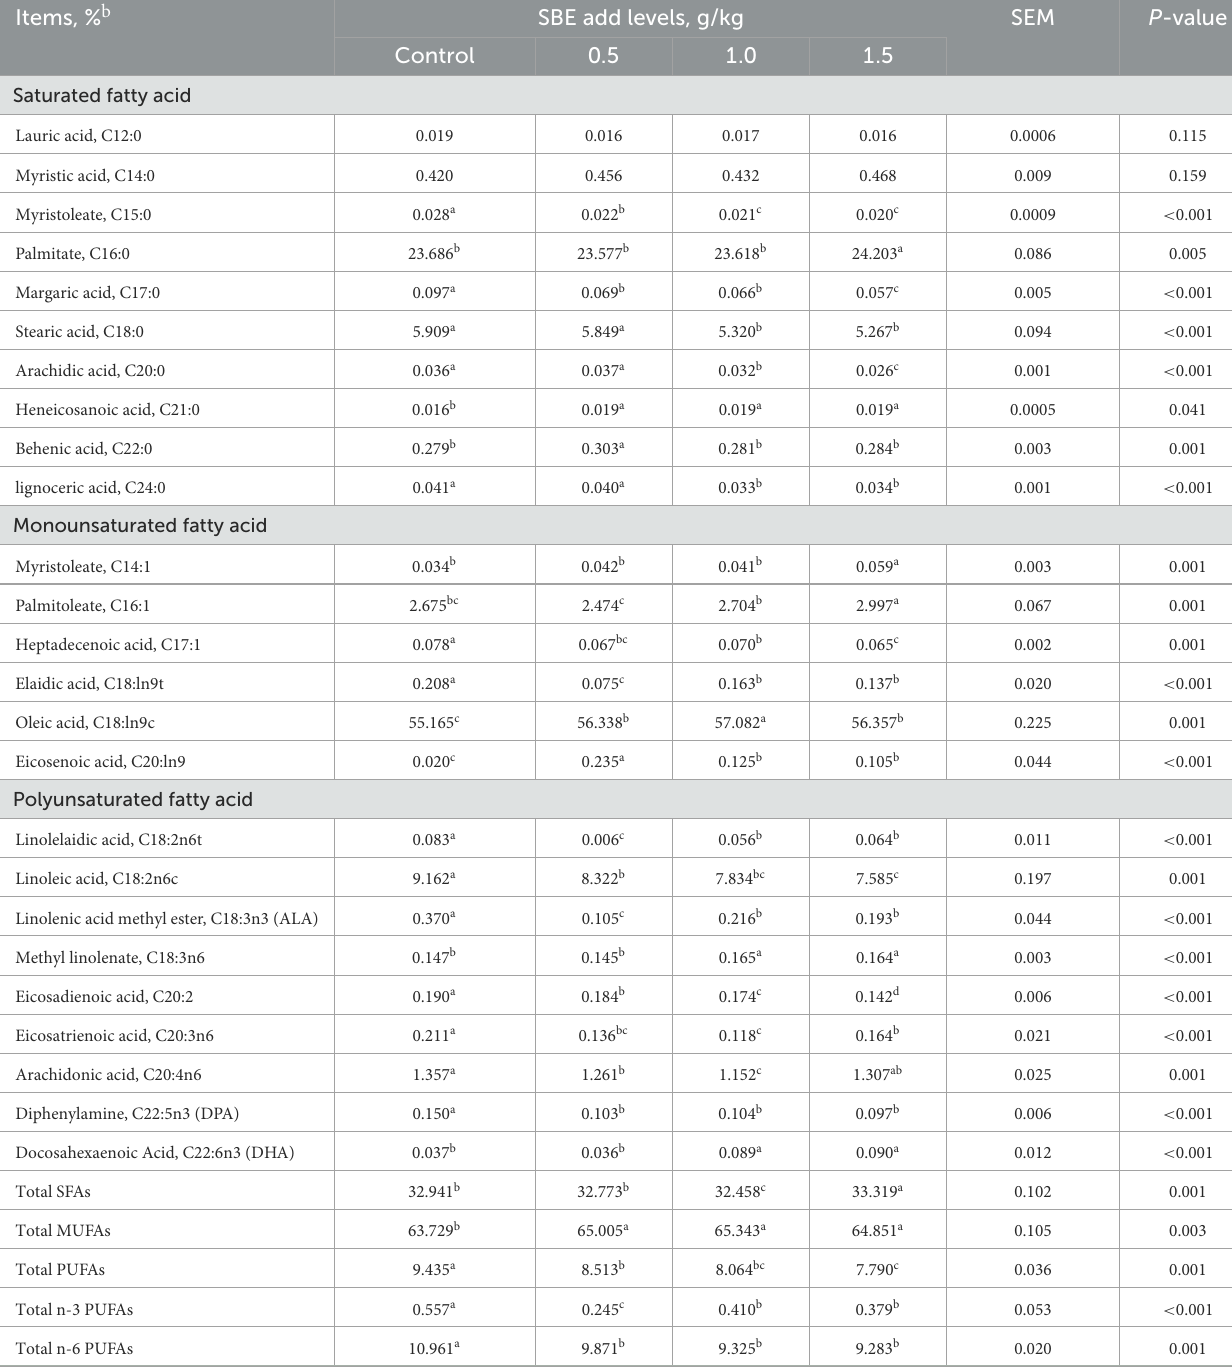
TABLE 6 Effect of dietary SBE on fatty acids in eggs a . Items, %